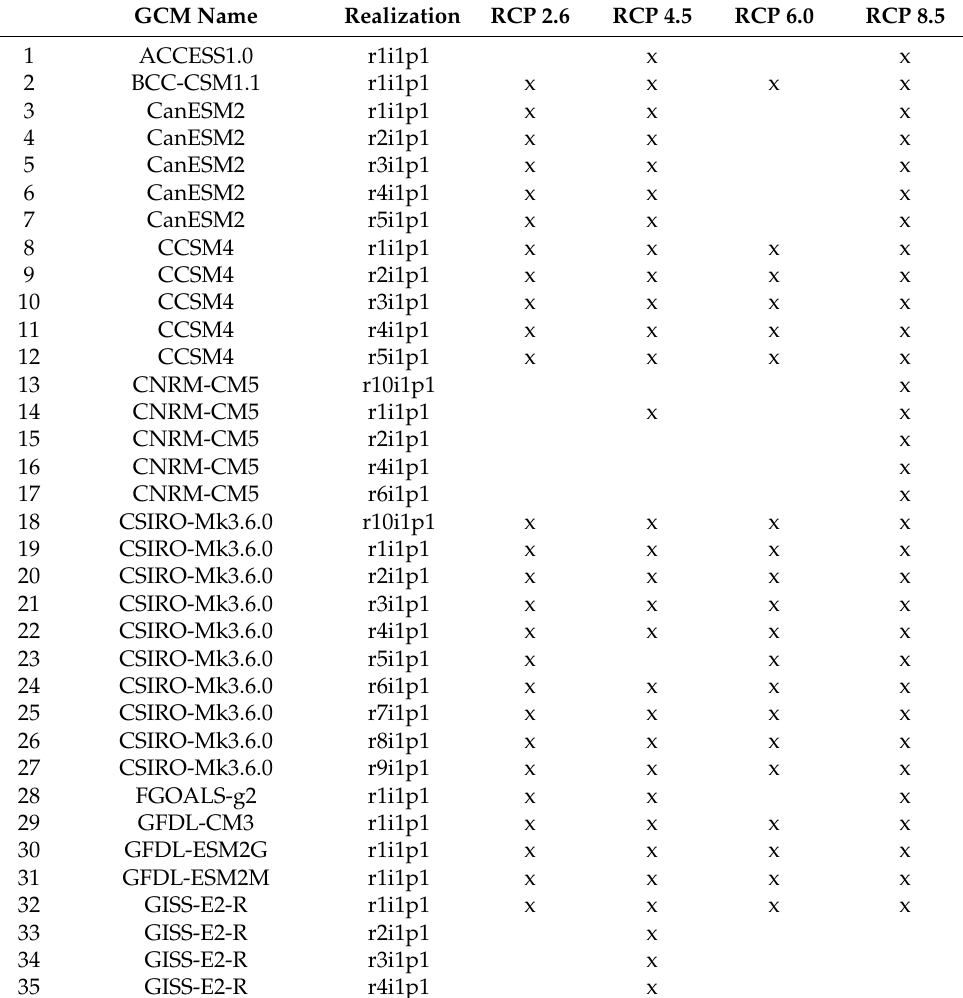
Table A1. General Circulation Models (GCM) and RCP scenarios used in this